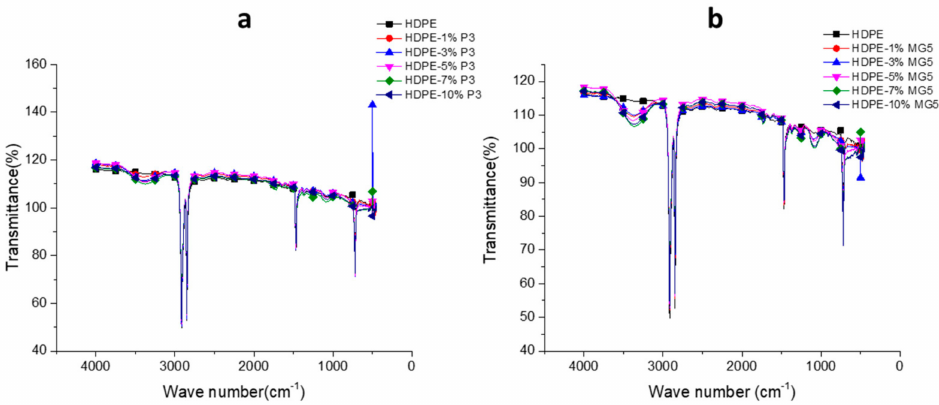
Figure 10. FTIR spectrums of ( a ) HDPE-P3 and ( b ) HDPE-MG5